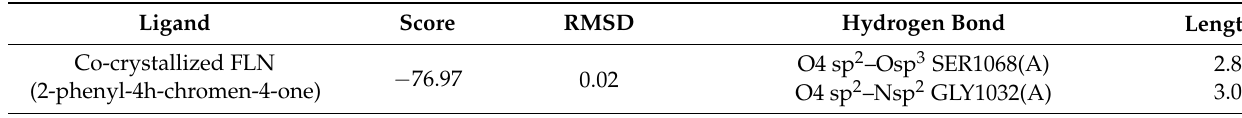
Table 2. Results of molecular docking study on human tankyrase 2 (PDB ID: 4HKI, chains A and C) [41].